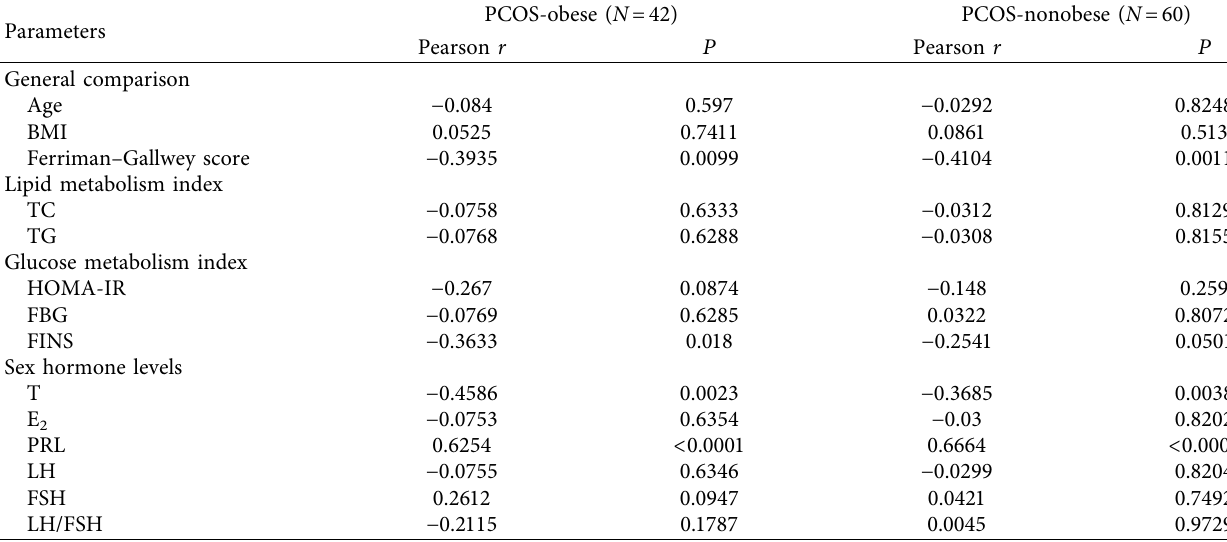
Table 3: Relationship between the expression of miR-124-3p in serum and the clinicopathological features of obese and nonobese PCOS patients.